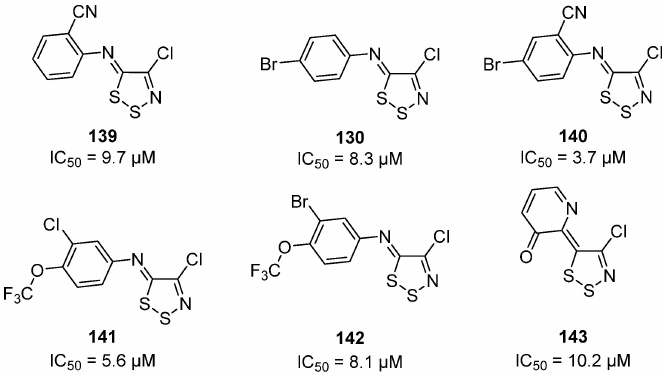
Figure 31. Anticancer 1,2,3-dithiazoles ASCT2 transport inhibitors.